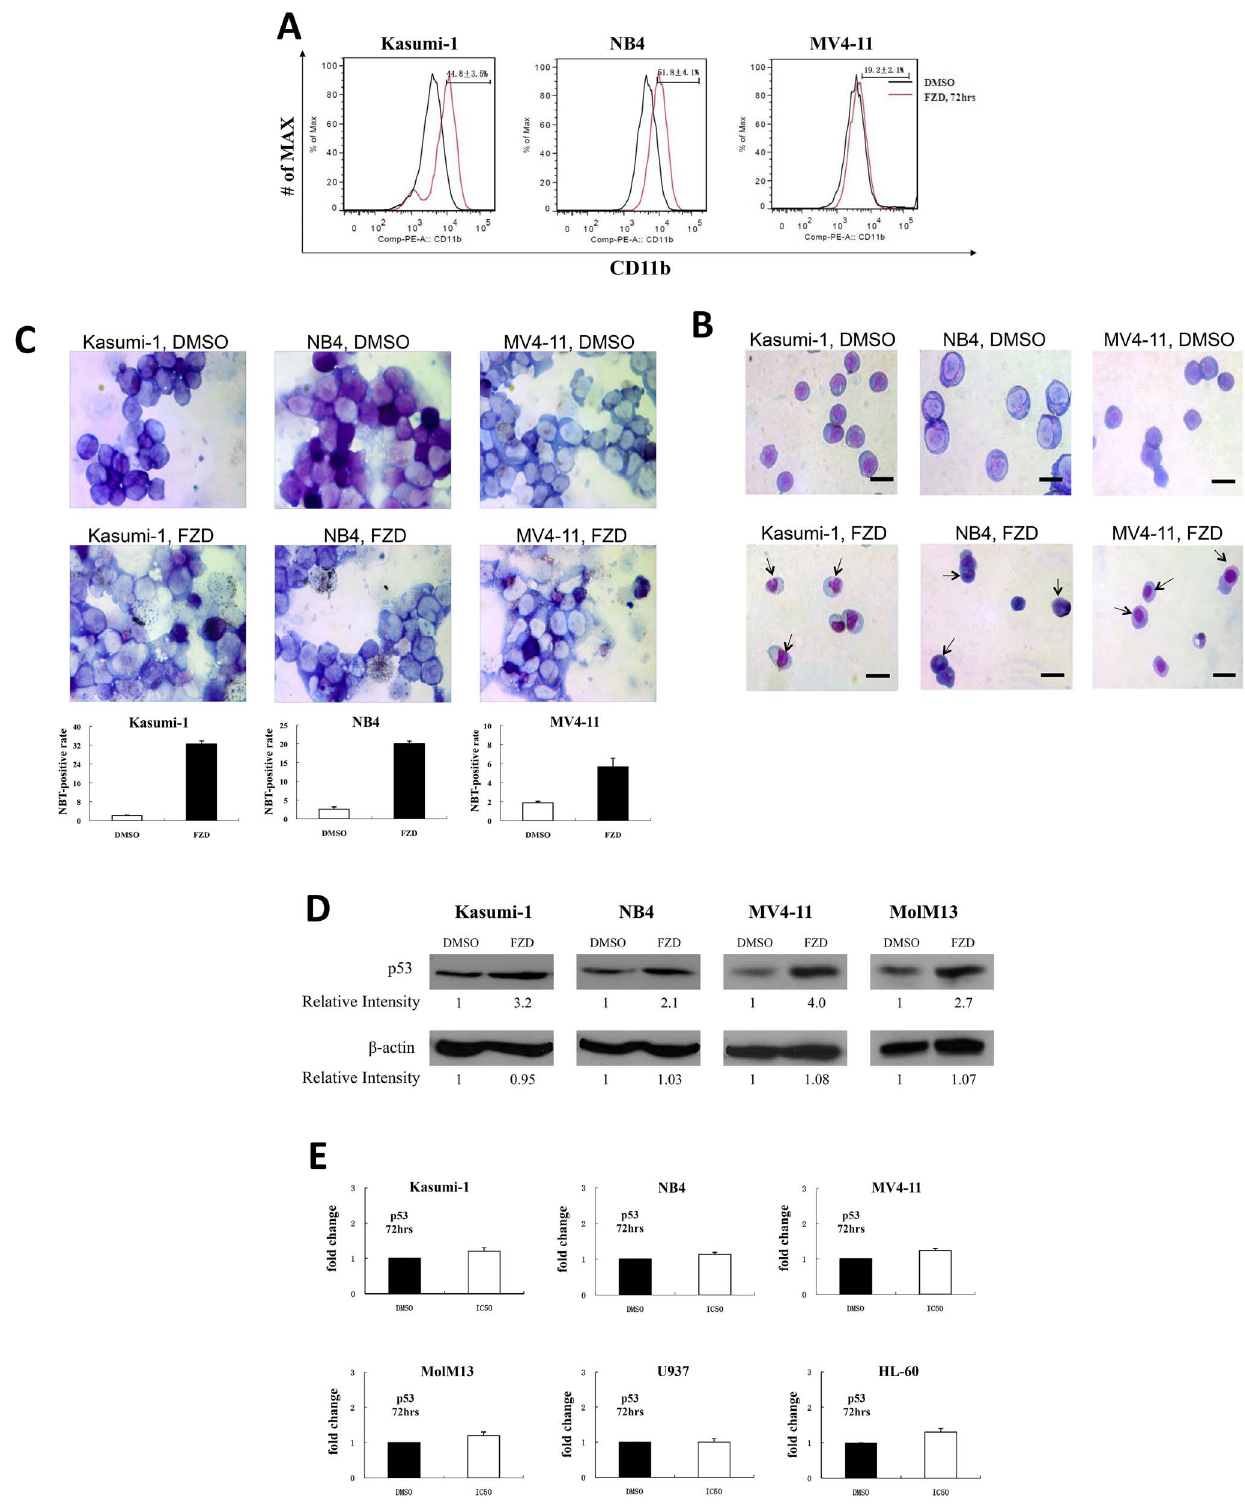
Figure 4. Furazolidone induces the leukemic cellular differentiation. (A) The myeloid differentiation antigen CD11b, was measured by FACS in Kasumi-1, NB4 and MV4-11 after FZD (predetermined concentration) and DMSO control treatment for 72 hours. The representative graph was from one of the three independent experiments. (B) The Giemsa staining of Kasumi-1, NB4 and MV4-11 cells treated with FZD (predetermined concentration) or DMSO control for 96 hours (magnification, 400 6 ). Arrows indicate nuclear condensation and multilobulated nucleus. Scale bars represent 10 m m. (C) Photomicrographs and the relative histograms (bottom panel) of the NBT reduction assay with Kasumi-1, NB4 and MV4-11 cells in the DMSO control group (top panel) and FZD treatment group (middle panel) for 72 hours (Giemsa stain; magnification, 1,000 6 ). There were many black particles (formazan) in the FZD treatment group of leukemia cells, so-called NBT-positive cells, which indicated that the AML cells had